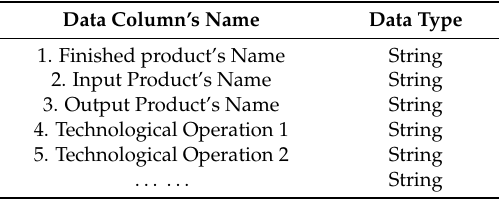
Table 5. Structure of the control data table.